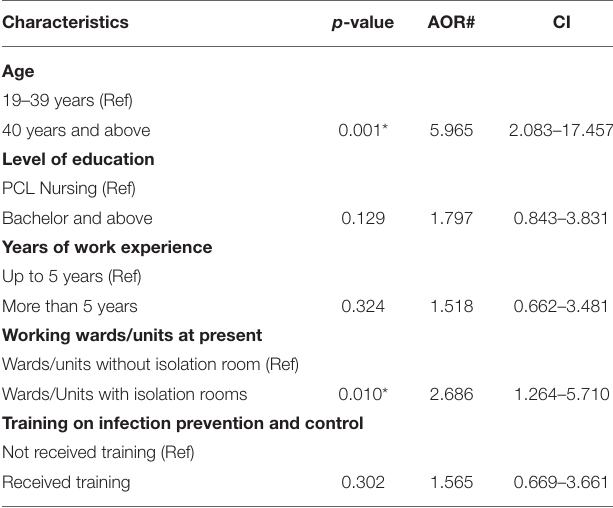
TABLE 5 | Association of background information with the knowledge of nurses about prevention and control of TB n =